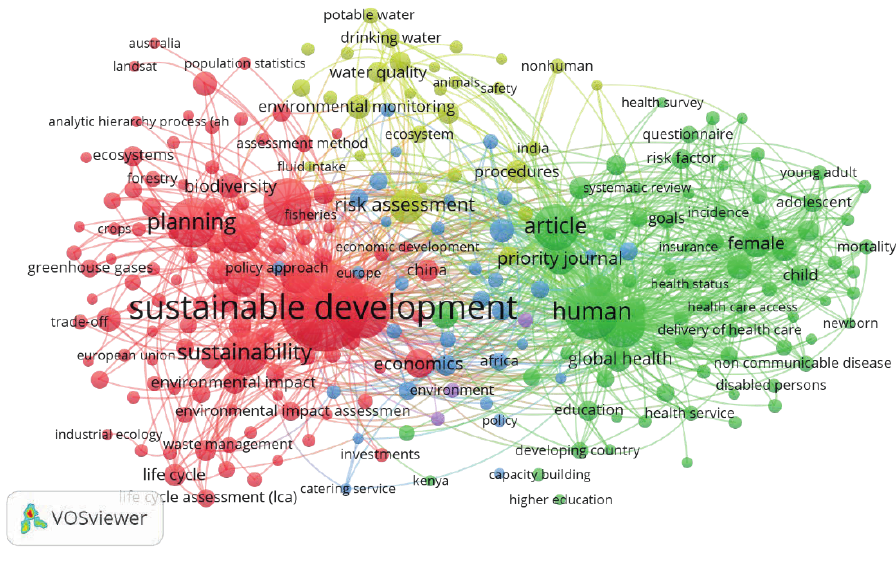
Fig. 2. Density of the main concepts and